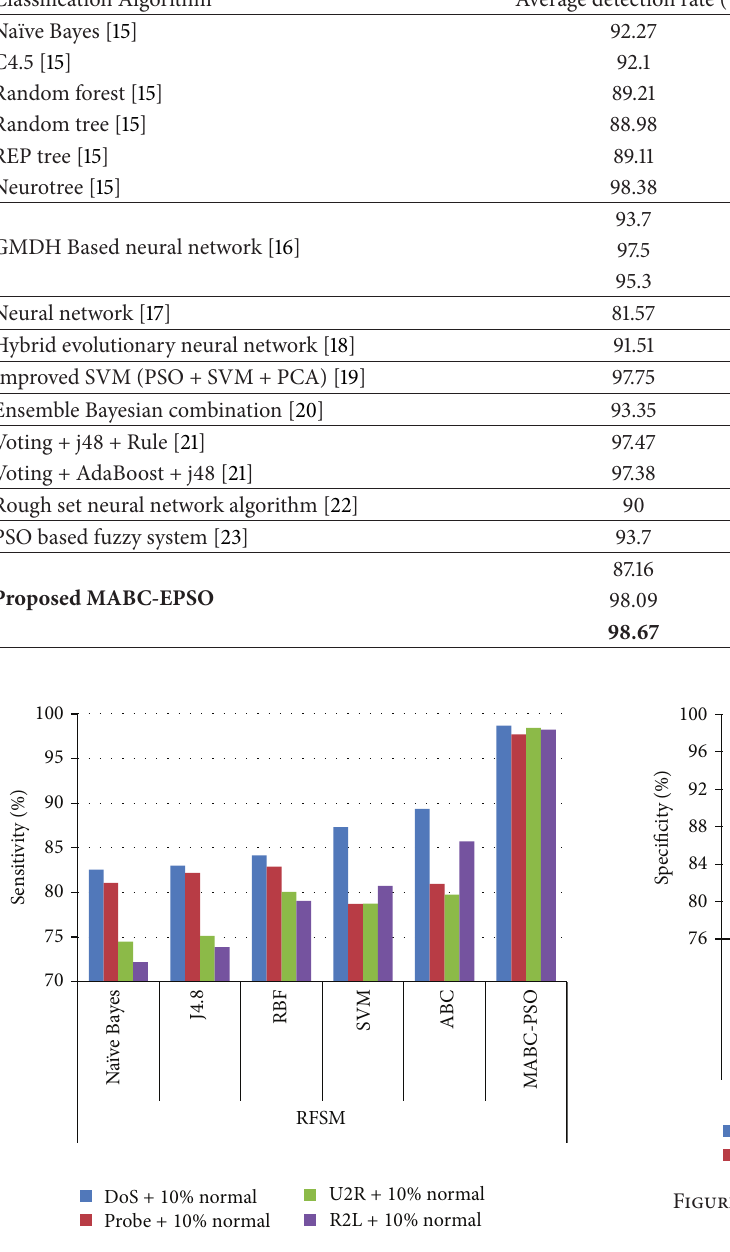
Figure 8: Comparison on sensitivity using RFSM method.